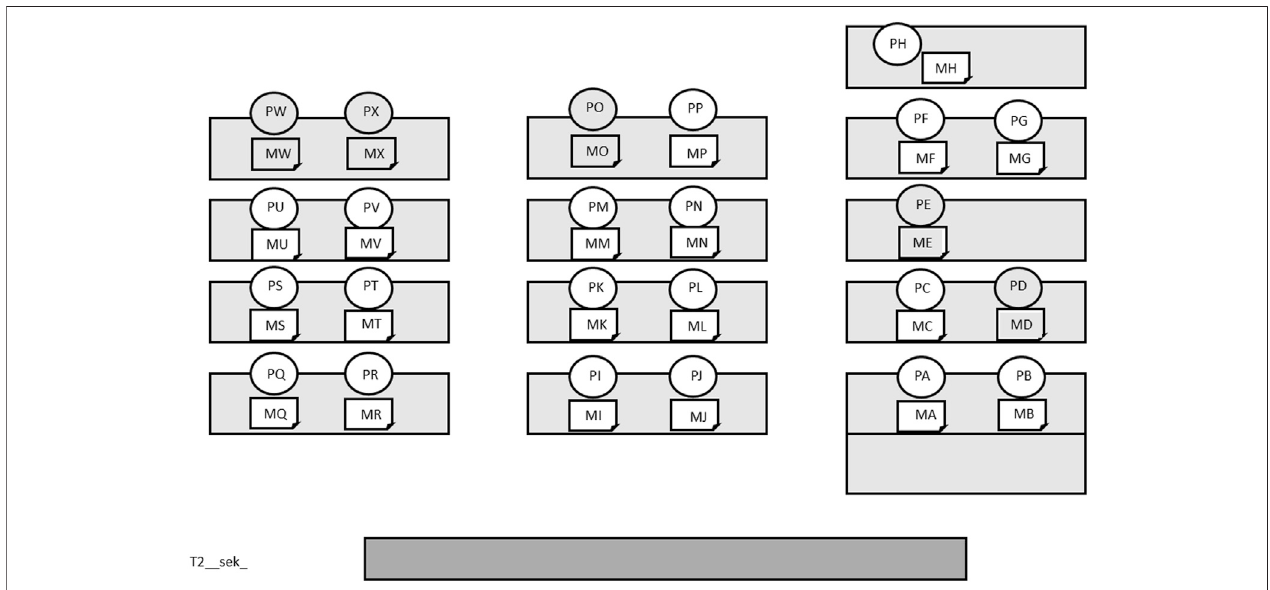
FIGURE 3 | Reference view for coding in SMI Semantic Gaze Mapping (T2, sequence